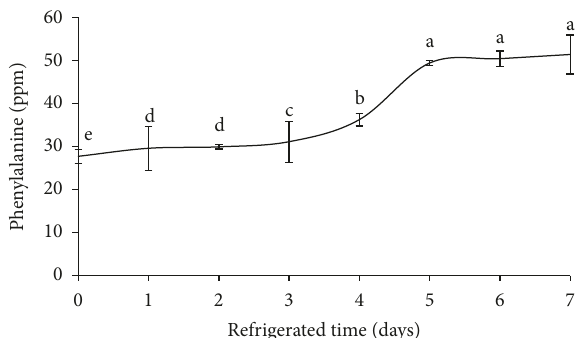
Figure 6: Creatine concentration of biofluids at 4 ∘ C for 7 days. Values are means ± SD ( n = 3). Different superscript letters indicate significant differences ( 𝑝 < 0.05 ).